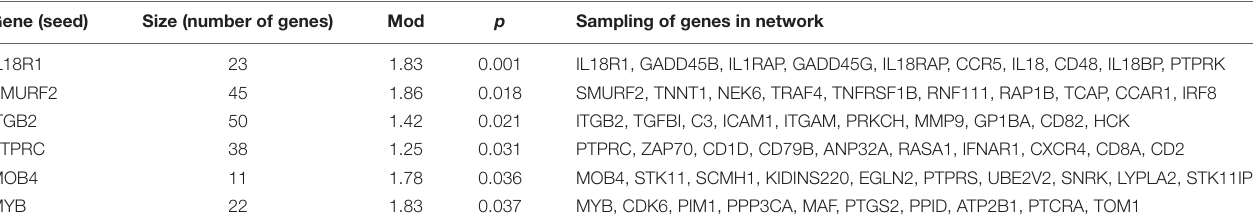
FIGURE 4 | Functional epigenetic protein–protein interaction modules for (A) IL18R1, (B) PTPRC, and (C) ITGB2. TABLE 6 | Functional epigenetic modules from protein–protein interaction